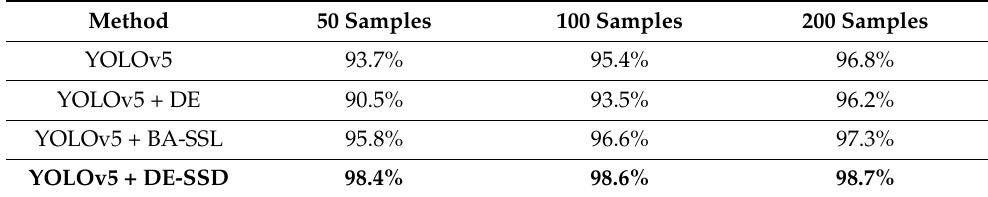
Table 4. Testing results of original YOLOv5, YOLOv5 with proposed BA-SSL framework, YOLOv5 with proposed DE strategy, and proposed DE-SSD on different amounts of labeled samples.